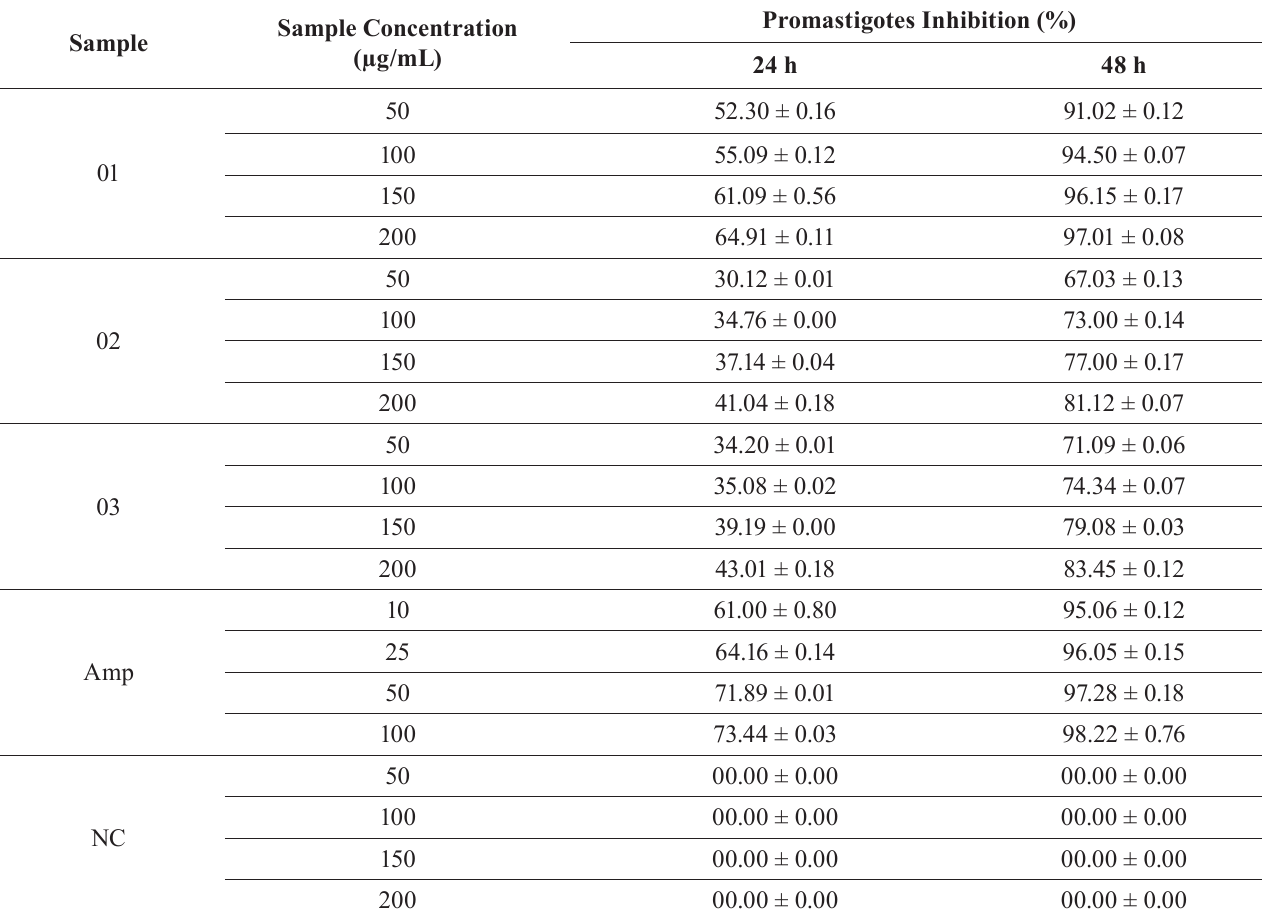
TABLE I - C ompounds in vitro anti-leishmanial effect